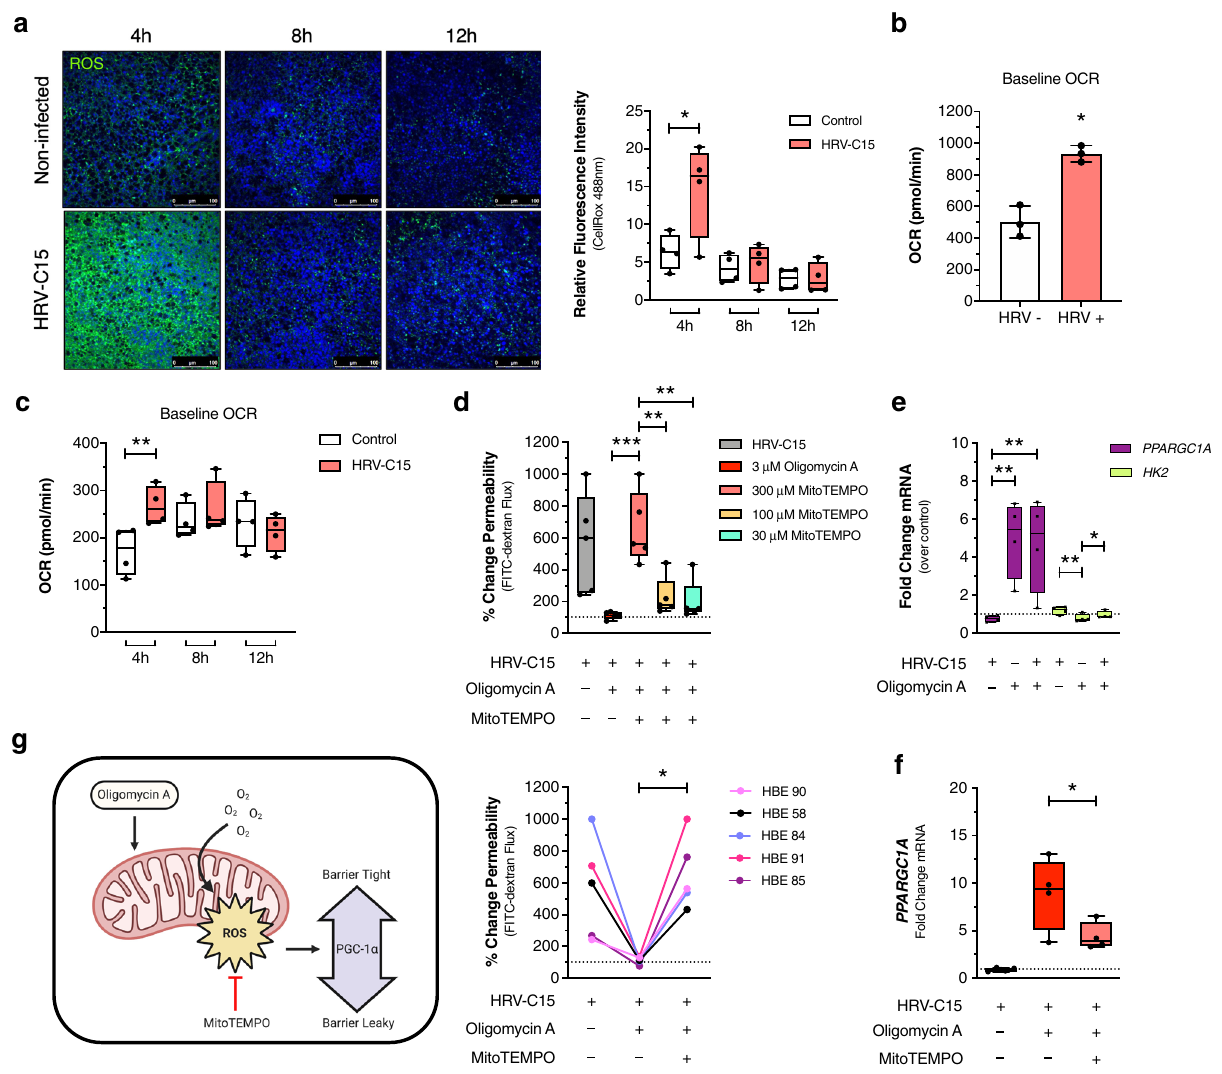
Fig. 5 Oxygen consumption fuels mitochondrial ROS to restore barrier function. a , Left: representative images of ROS in live HRV-C15-infected ALI cultures over 12 h, detected by CellROX (green) and nuclei by Hoechst 33342 (blue). Scale bar, 100 μ m. Right: Quanti fi cation of CellROX fl uorescence. Representative confocal images and quanti fi cation were obtained from four independent experiments performed in ALI cultures derived from four different lung donors and selected from three fi elds per condition per donor. Data are represented as boxplots of means of three fi elds of view per donor per condition and analyzed by two-way ANOVA with Sidak ’ s multiple comparisons: ** p = 0.005, n = 4 donors. b ALI cultures were infected with HRV-C15 or mock for 4 h, biopsy punched (4 mm), loaded into Seahorse XFe24 plates and baseline OCR was measured for three cycles. Individual donor points represent a mean of three technical replicates (biopsy punches) per donor per condition ± SD and analyzed by two-tailed paired t test: * p = 0.039, n = 3 donors. c ALI cultures were infected with HRV-C15 or mock to perform Seahorse measurements on all matched timepoints simultaneously using staggered infections. ALI inserts were biopsy punched (2 mm), loaded into Seahorse XFe24 plates, and baseline OCR was recorded for four cycles. Data are represented as boxplots in one fi gure for optimal visualization comparison. Individual donor points represent the mean of four technical replicate punches per donor (four biopsy punches per condition per time point per donor) and analyzed by two-tailed paired t test: ** p = 0.04, n = 4 donors. d Top: MitoTEMPO (mitochondrial ROS scavenger) dose response in HRV-C15-infected ALI cultures treated with 3 μ M oligomycin A, and permeability assessed by FITC-dextran (3 – 5 kDa) fl ux at 12 h post infection. Data are represented as boxplots and analyzed by one-way ANOVA with Holm – Sidak multiple comparisons: left to right *** p = 0.0003, ** p = 0.002, ** p = 0.001, n = 5 donors. Bottom: FITC-dextran (3 – 5 kDa) permeability of 300 μ M MitoTEMPO barrier loss from oligomycin A restoration at 12 h post infection. Data are represented as individual HBE donor lines and analyzed by one-way ANOVA with Holm – Sidak multiple comparisons: * p = 0.015, n = 5 donors. e PPARGC1A and HK2 mRNA expression affected by 3 μ M oligomycin A treatment at 12 h post infection. Matched samples represented as boxplots in the same fi gure for optimal visualization comparison with each gene analyzed independently by one-way ANOVA with Holm – Sidak multiple comparisons: PPARGC1A ** p = 0.008, * p = 0.008, HK2 ** p < 0.006, * p = 0.039, n = 4 donors. f PPARGC1A mRNA expression affected by 3 μ M oligomycin A with or without 300 μ M MitoTEMPO. Data are represented as boxplots and analyzed by one-way ANOVA with Dunnett multiple comparisons: * p = 0.04, n = 4 donors. g Graphical representation of mitochondrial ROS involvement in PGC-1 α expression and barrier function to summarize fi ndings from ( a – f ). Graphic created using BioRender. Data represented as boxplots indicate the median (center line), upper and lower box bounds (IQR = fi rst and third quartiles), and whiskers (min and max values), with individual donor data points superimposed onto the